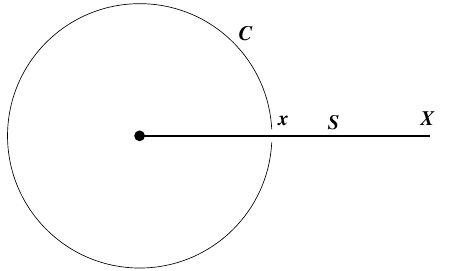
Figure 1 . The potential (cid:31) b is made single-valued by removing the union of paths S n from each argument x n to an arbitrarily chosen point X .